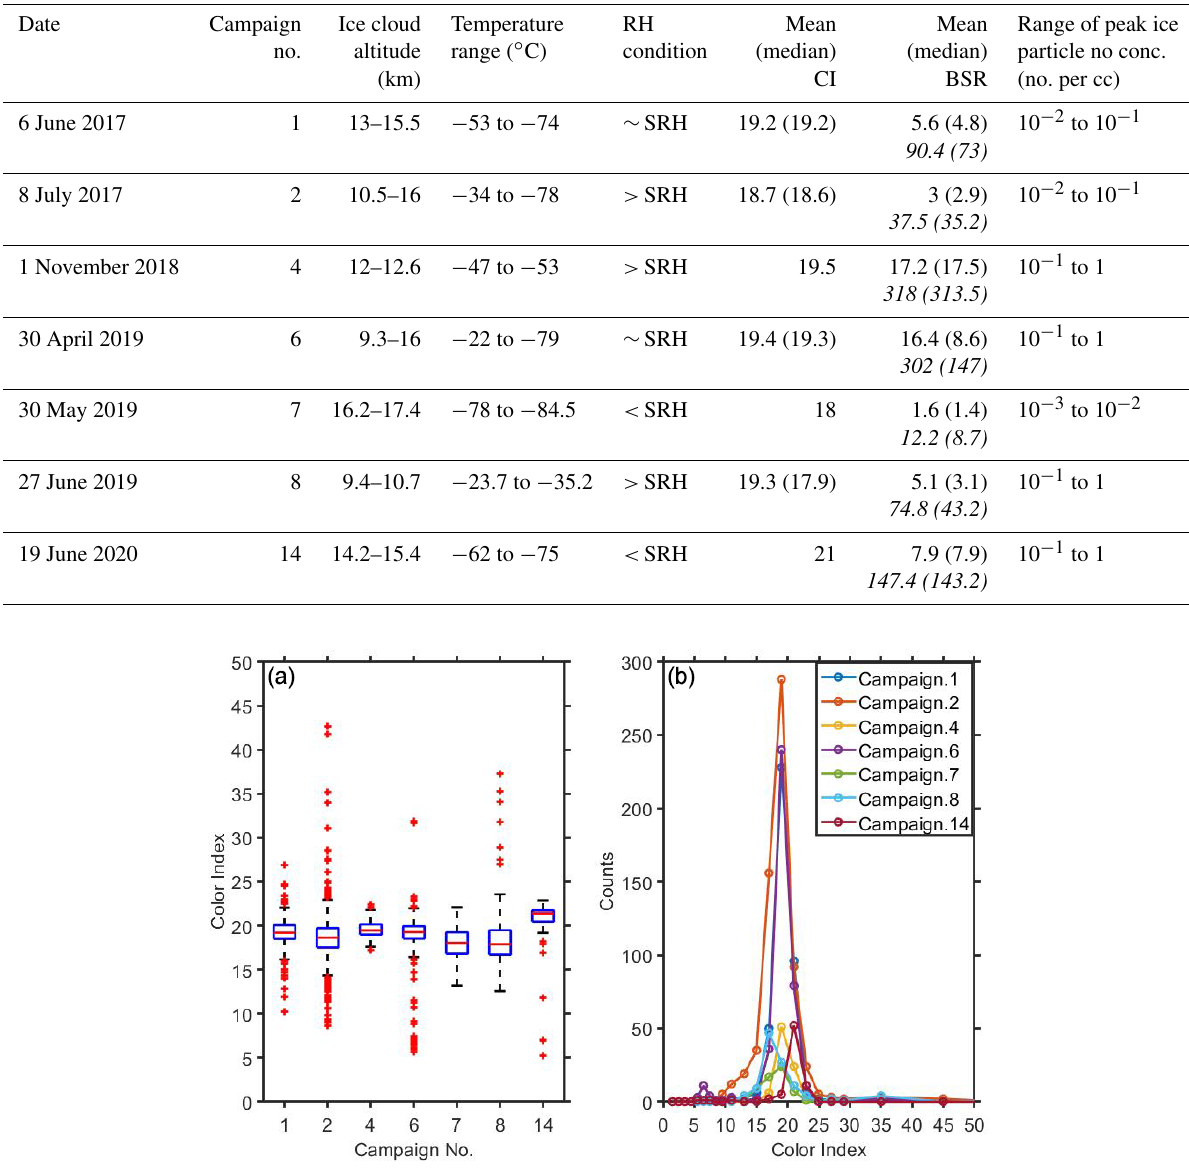
Table 3. Colour index (CI) and other physical parameters of the ice clouds. The backscatter ratio (BSR) in roman (italic) font is for a 450nm (940nm) channel.